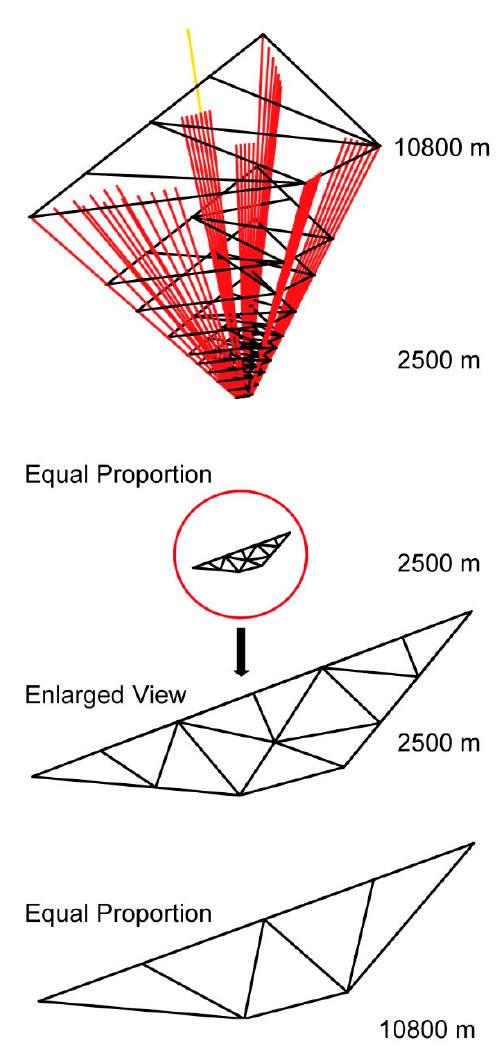
Figure 6. Distribution of GNSS signals at each tomographic plane; top panel: all the nodes (triangles vertices) are adjusted to an equidistant position on each plane; middle panel: equal proportion and enlarged view of the nodes at the height of 2500 m; bottom panel: equal proportion of the nodes at the height of 10,800 m.